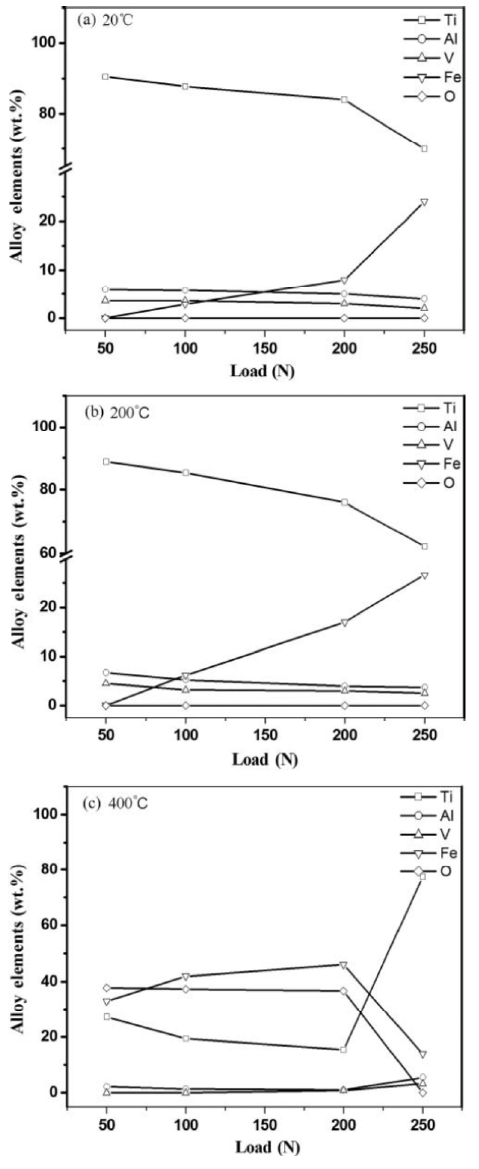
Fig. 10 EDX results of worn-pin Ti64 surfaces slid under various loads (50–250 N) at distinct temperature conditions: (a) 20 ° C; (b) 200 ° C; (c) 400 ° C. Reproduced with permission from Ref. [113]. Copyright Taylor & Francis,